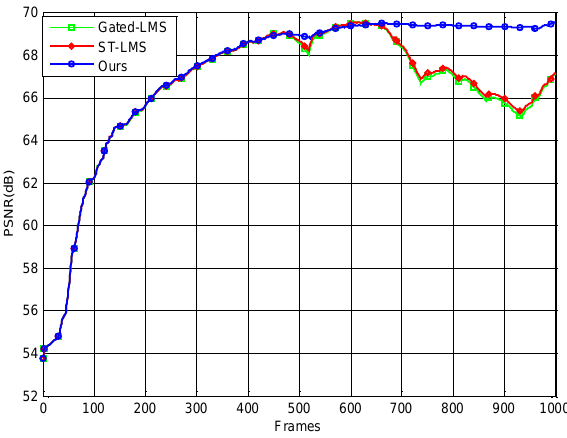
Figure 6. PSNR versus frame number for the tested algorithms using simulated nonuniformity data.